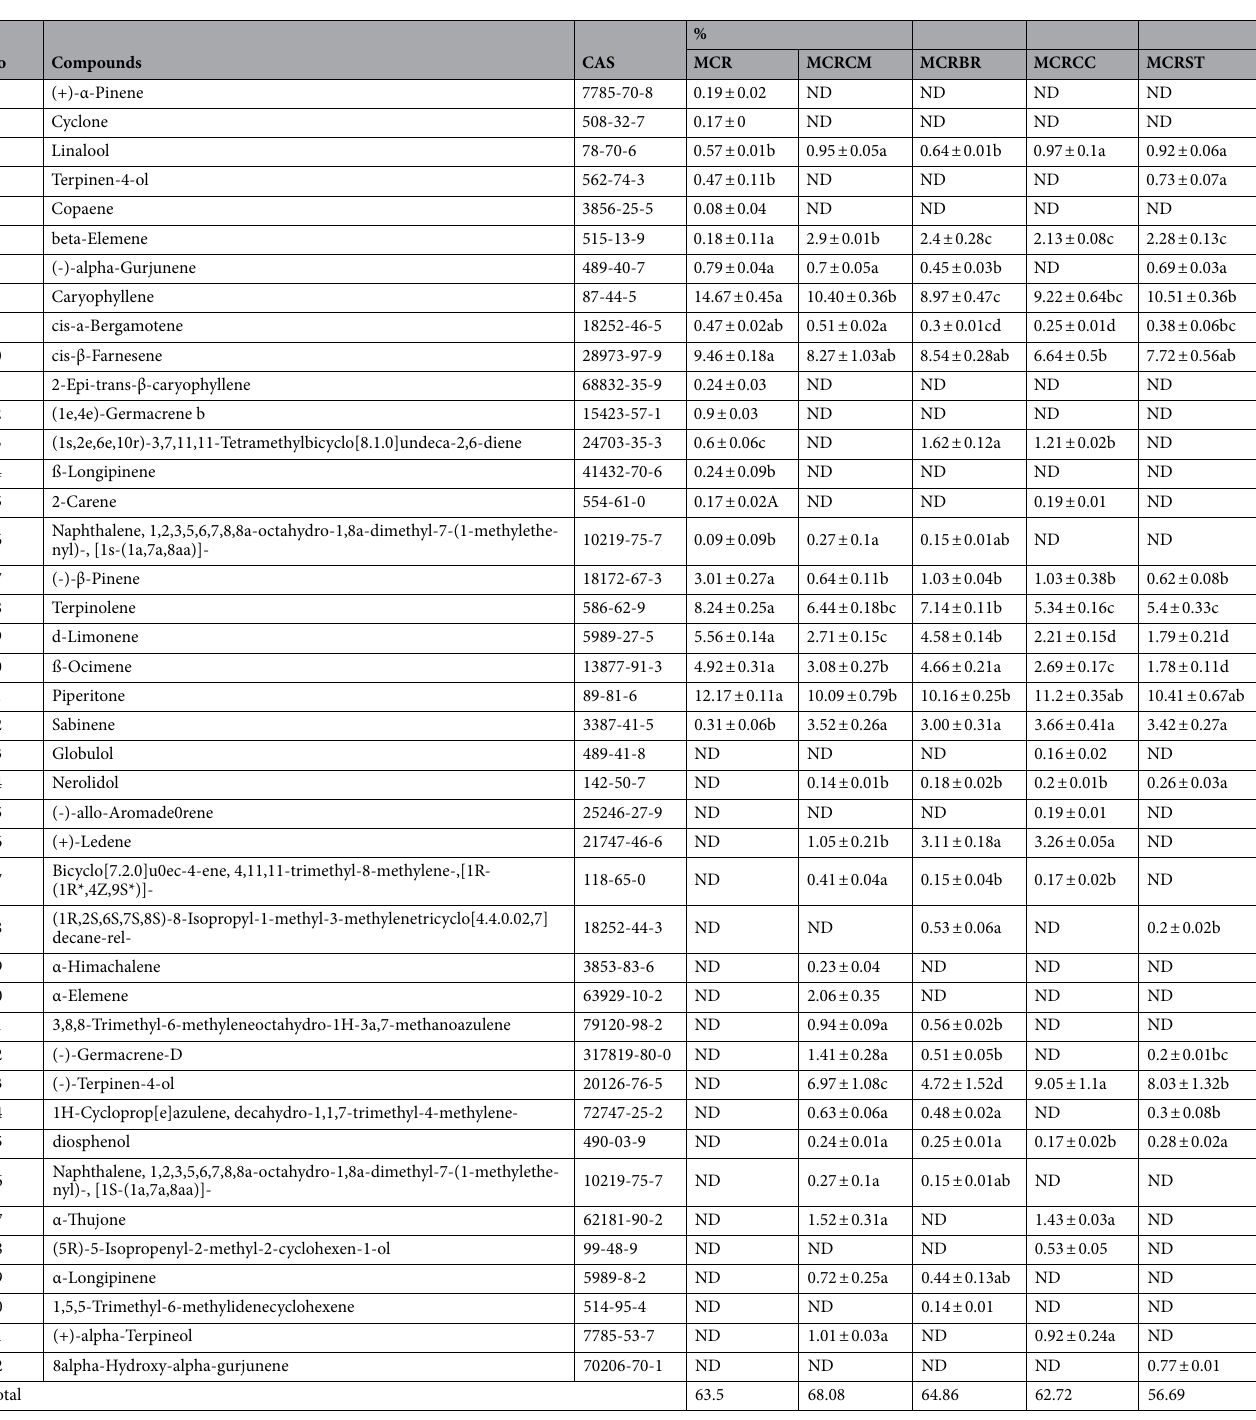
Table 1. Effects of mixed ensilage on the VOCs of terpenes in MCR. CAS, chemical abstract service; ND, not detected; experiments were performed in triplicate and shown are the means ± S.D., different lowercase letters correspond to a significant difference at the 0.05 level (Duncan’s new multiple range test). The same as Table